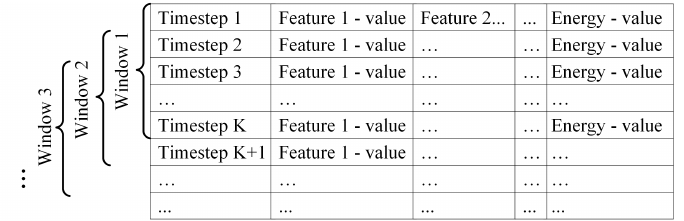
Figure 4. Sliding Window